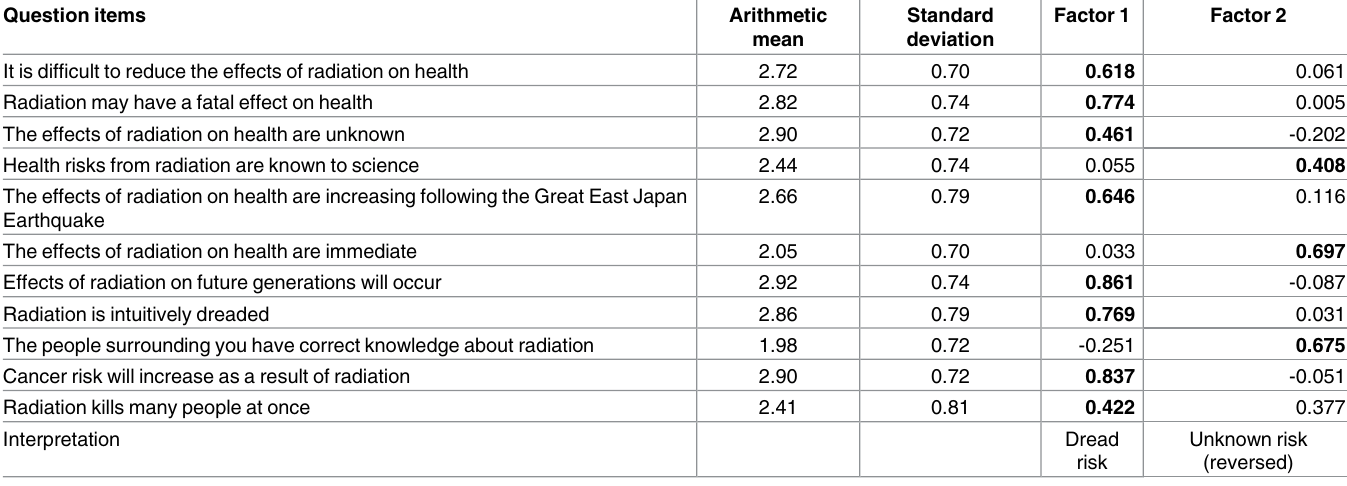
Table 2. Arithmetic mean, standard deviation, and factor pattern matrix for perception of radiation risk, and their interpretation. KMO: 0.918, P < 0.001 (Bartlett). Bold font: > 0.40 or < –0.40. Cronbach’s α : 0.878 (eight items in bold font for factor 1); 0.578 (three items in bold font for factor